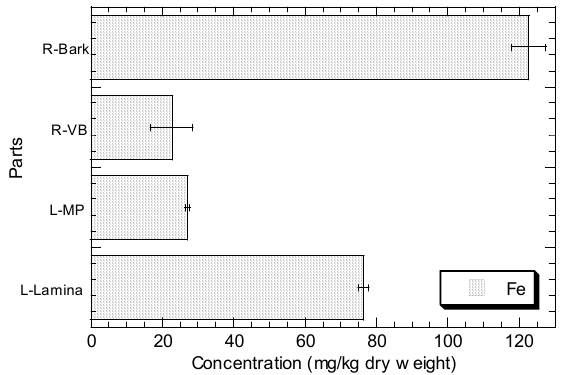
Figure 2. Concentrations (mean ± standard error, mg/kg dry weight) of Cu, Fe, Ni, Pb, and Zn in the root barks (R-Bark), root vascular bundles (R-VB), leaf midrib plus petiole (L-MP), and leaf lamina (L-Lamina) of Rhizophora apiculata collected from Sepang (S3). The concentrations of Cu, Fe, Ni, Pb, and Zn in the MP), lamina of R. apiculata , and their habitat surface of four geochemical fractions in the sediments, are presented in Figure 3a. The clustering patterns of the nine sampling sites for Cu, Fe, Ni, Pb, and Zn, based on the metal concentrations in the leaves (lamina and midrib plus petiole) and the geochemical fractions of the sediments, are presented in Figure 3b.